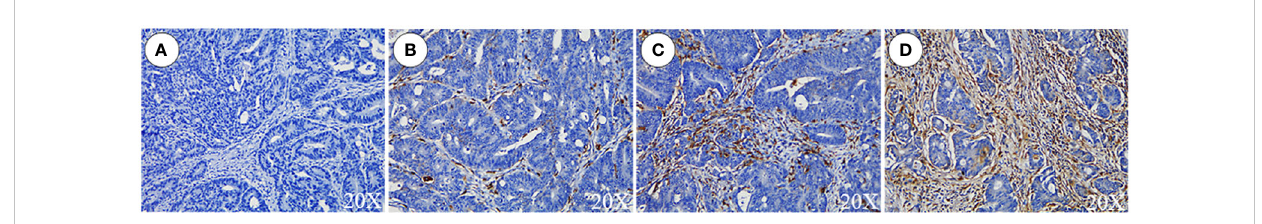
FIGURE 1 Grade scoring of CD68+ TAMs in tumor stroma of primary tumors. (A) None/sporadic. (B) Moderate. (C) Abundant. (D) Highly